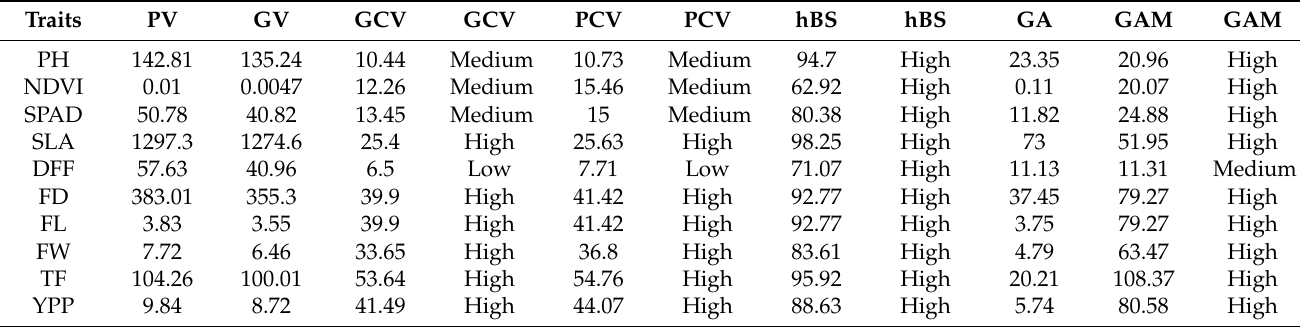
Table 6. Estimation of statistical and genetic parameters of yield and its contributing traits of different eggplant germplasm. Traits